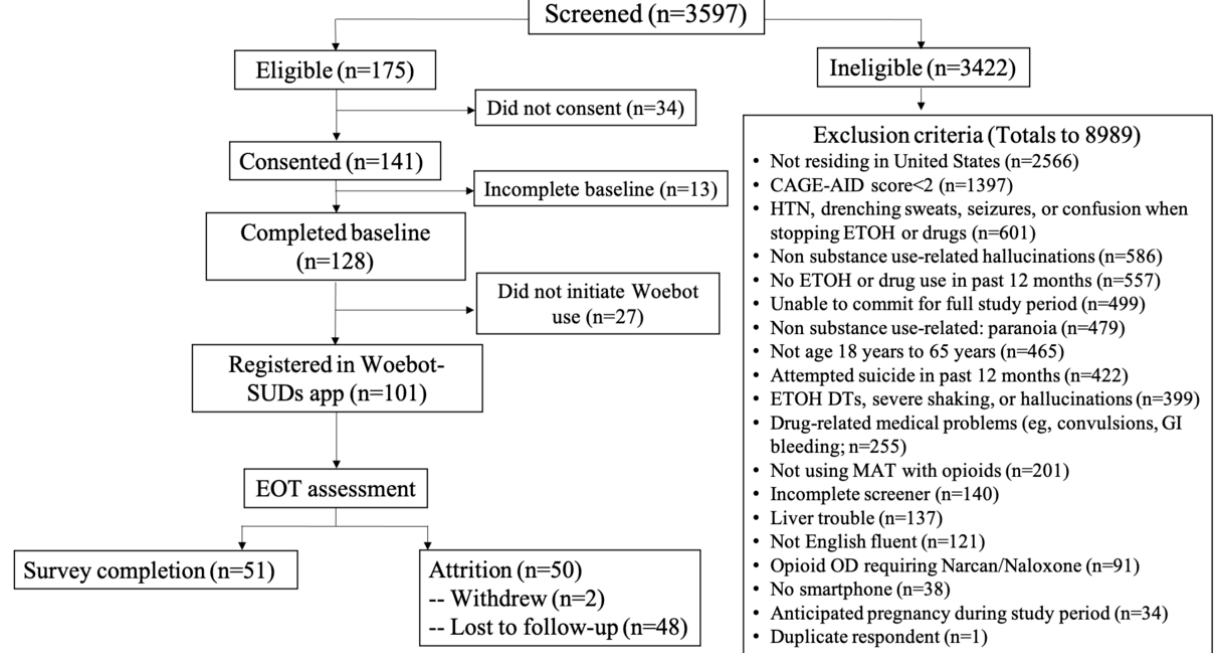
Figure 1. Study consort diagram. CAGE-AID: Cut down, Annoyed, Guilty, Eye Opener-Adapted to Include Drugs; DTs: delirium tremens; EOT: end of treatment; ETOH: ethyl alcohol; HTN: hypertension; MAT: medication-assisted treatment; OD: overdose; Woebot-SUDs: Woebot for the treatment of substance use